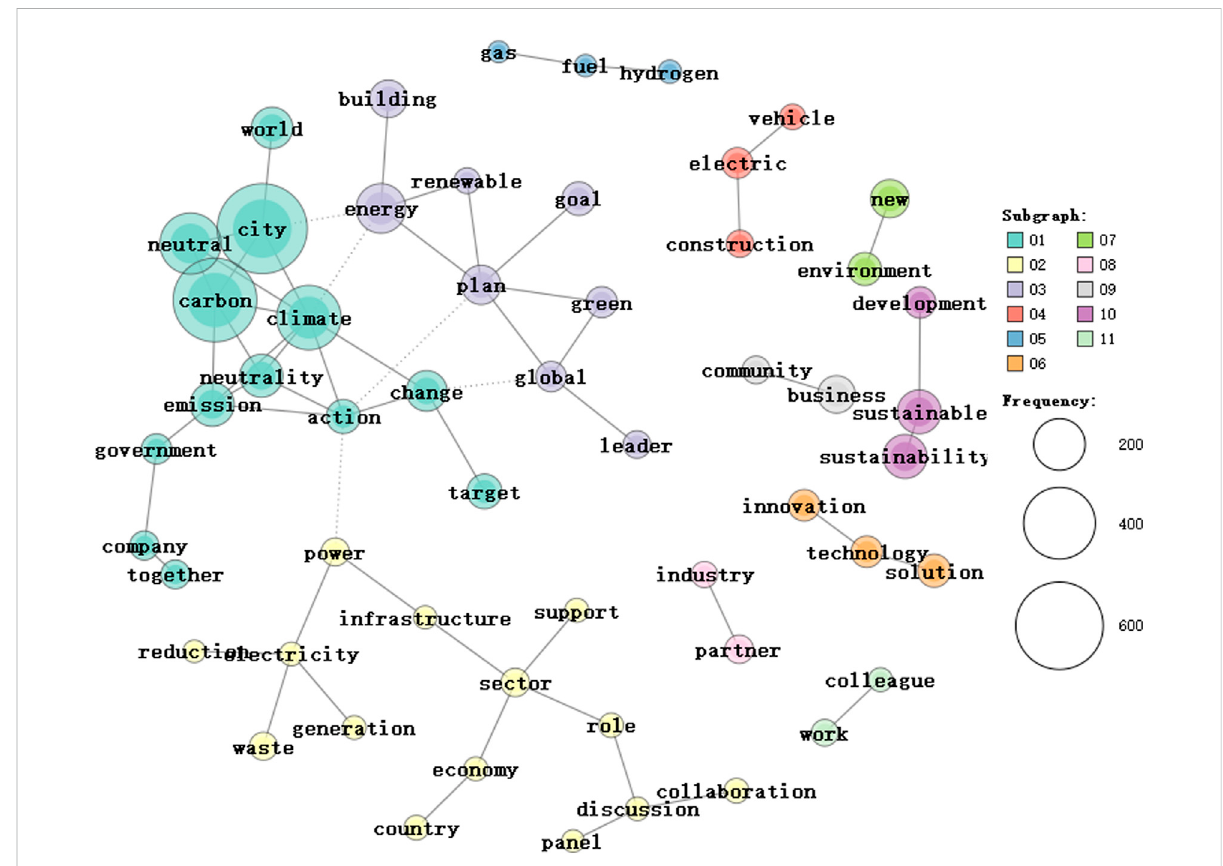
Clusters analysis in the context of carbon-neutral city from LinkedIn.